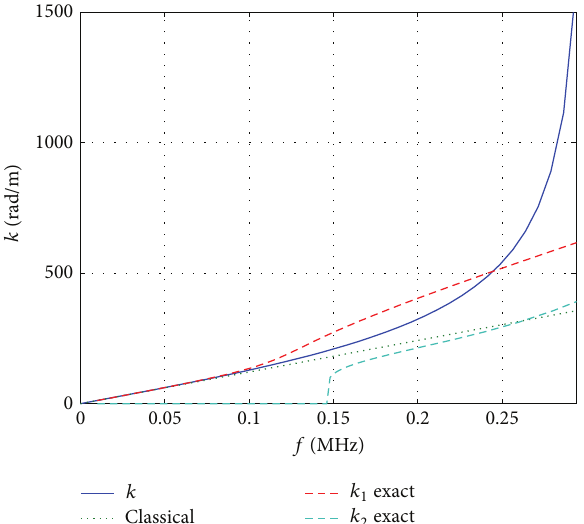
Figure2:DispersioncurveforarodusingtheRayleigh-Lovetheory, compared to the classical and exact